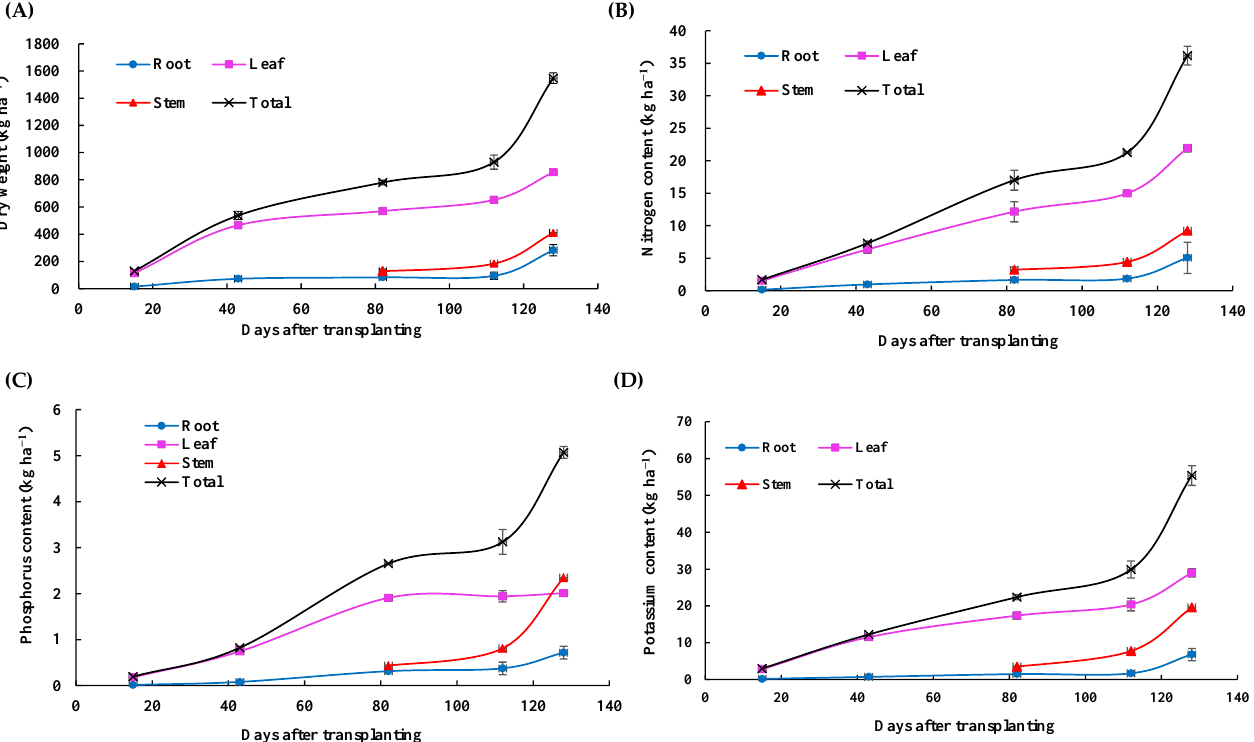
Figure 7. Accumulation and distribution of dry matter and nutrients after transplanting in lettuce. ( A ) Dry weight; ( B ) Nitrogen content; ( C ) Phosphorus content; and ( D ) Potassium content.